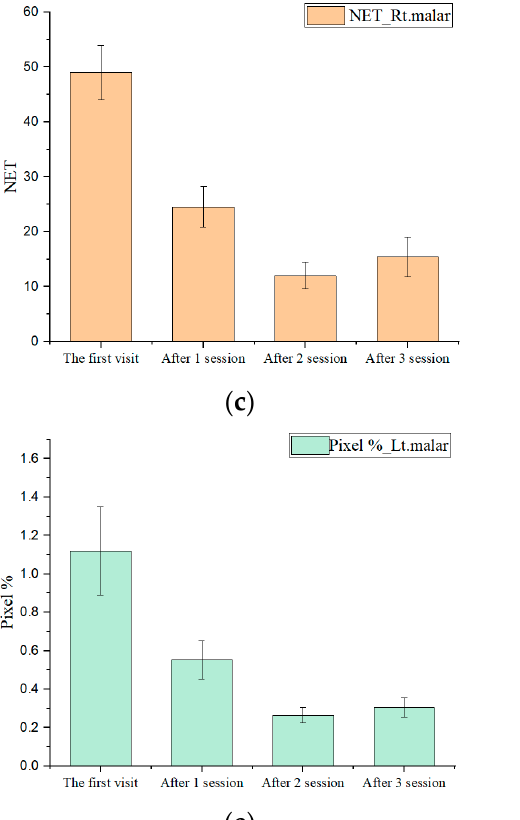
Figure 3. Graphs of NET (number of lesions exceeding the erythema threshold) and pixel % (sum- mation of the area exceeding the erythema threshold) at each session ( a ) NET of the forehead. ( b ) NET of left malar. ( c ) NET of right malar. ( d ) Pixel % of the forehead. ( e ) Pixel % of the left malar. ( f ) Pixel % of the right malar (* p < 0.05).